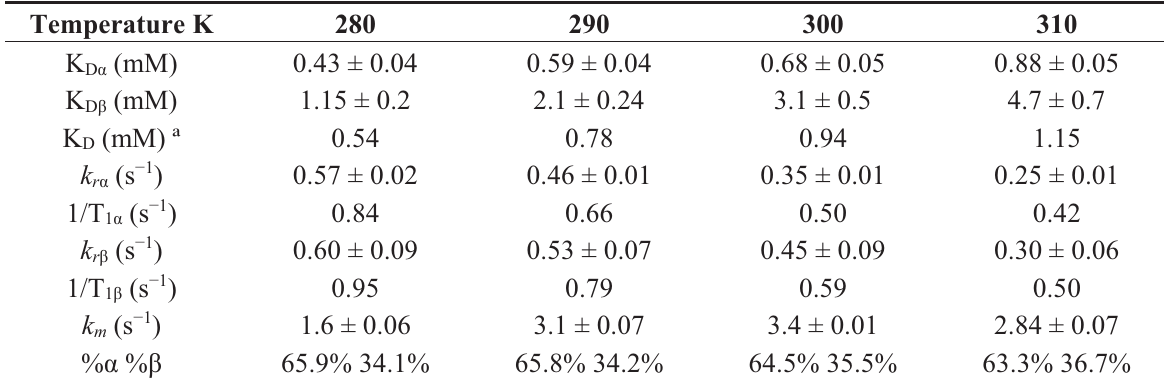
Table 1. (cid:3)- and (cid:5)-2FDM dissociation (K D(cid:3) and K D(cid:5) ), magnetization ( k m ) and relaxation constants ( k r (cid:3) and k r (cid:3) ) calculated by fitting to differential kinetic equations with DynaFit [51]. Experimental relaxivities (R = 1/T 1 ) and anomeric ratios were measured at each temperature by inversion recovery NMR experiments and 1D- 19 F spectral information obtained from the ratio of the corresponding peak of each anomer, respectively. Errors correspond to the standard deviation for each parameter obtained after non-linear fitting. For comparison, the calculated combined macroscopic dissociation constant corresponding to the total monosaccharide concentration is